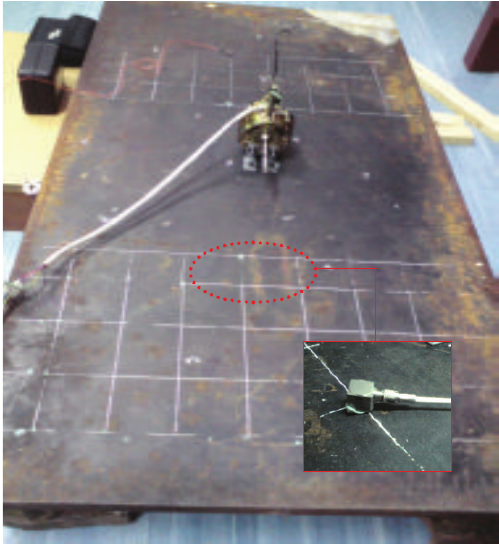
Figure 10: The electrical fan motor on the low mobility reception plate.